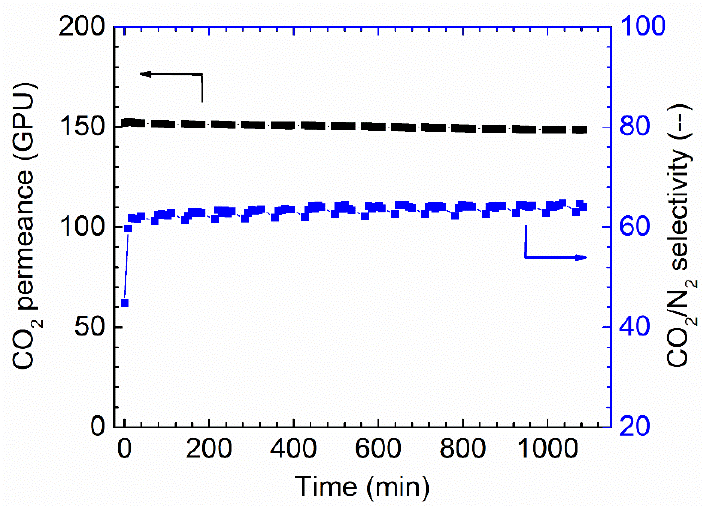
Figure 8. Stability performances of Pebax membrane in the dry state (1 wt.%), 0% RH, feed pressure of 2 bar at 35 °C.